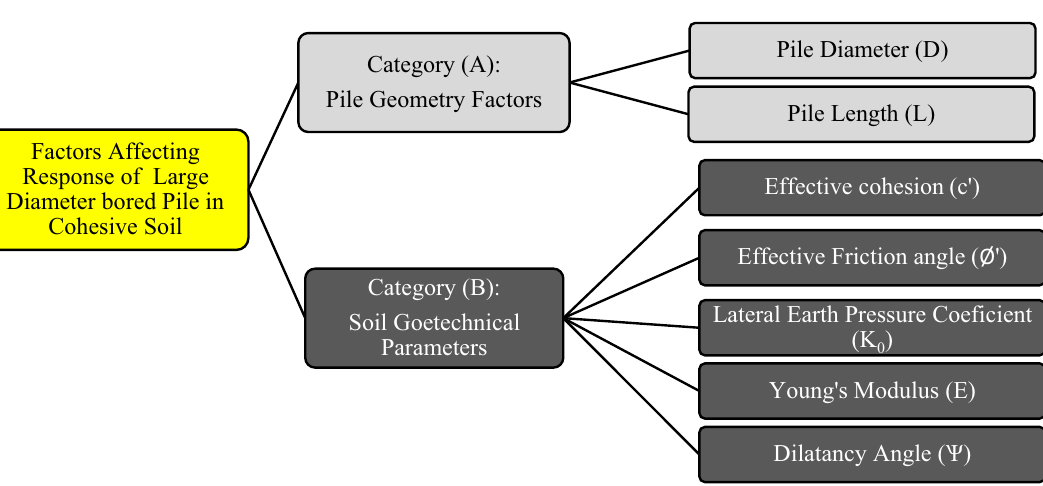
Figure 4. Factors affecting large diameter bored pile behavior (After Al-Atroush et al. 6